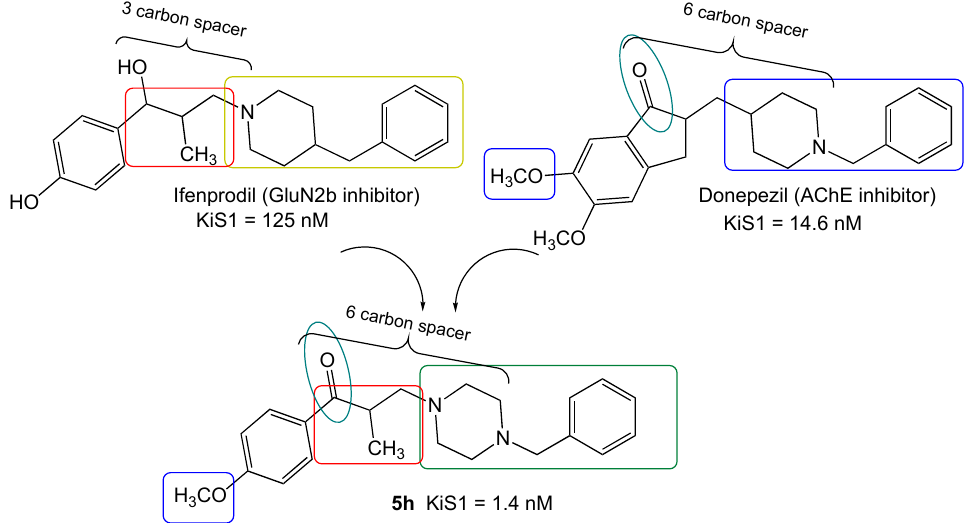
Figure 2. Molecular hybridization approach for newly synthesized compounds.